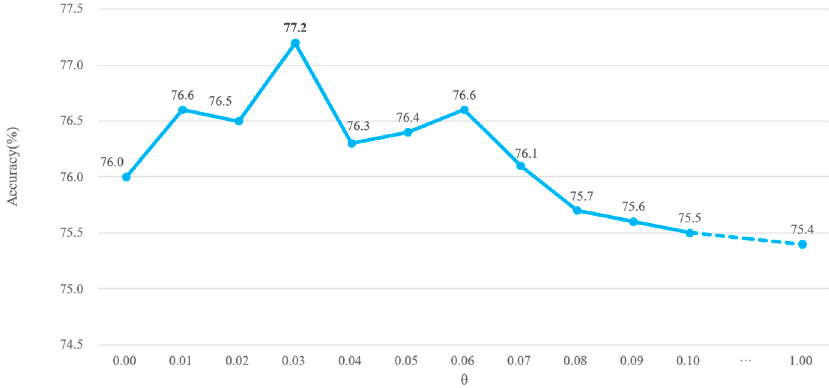
Figure 6. Illustration of the effect of the hyperparameter θ in TACMA. The best result is in bold.